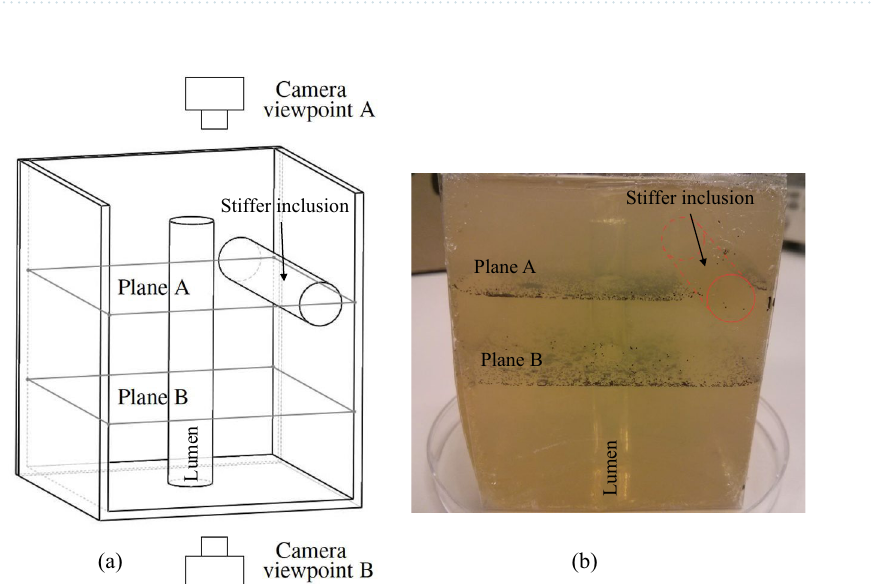
Figure 4. Approximate location of the planes with patterns of particles in the ( a ) the mould design for the phantom. Plane A contained a section of the inclusion whilst plane B did not. The viewpoints for the camera differed for each plane with particles. ( b ) Completed phantom placed on a Petri dish. Both planes of particles are visible, as well as the vertical lumen conduit and the stiffer inclusion (dashed red